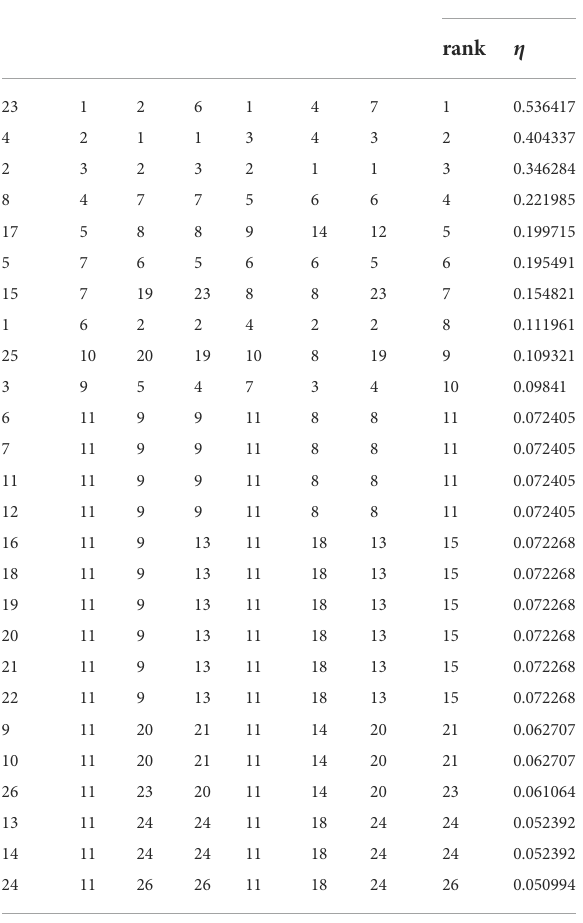
TABLE 2 The ranking of the nodes in the example network is calculatedbytheBC,CC,SL,DIL,NC,andENCmethods,aswellas by the ranking of the nodes and the rate of decrease in the ef fi ciency of the network after node deletion using the NDM.